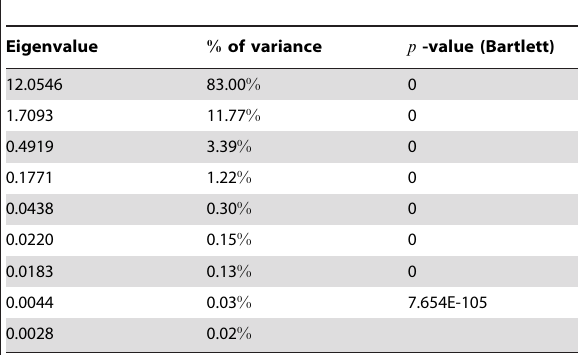
Table 2. Results of the principle component analysis: eigenvalues, percentage of variation represented by each principle component and Bartlett test p-values.